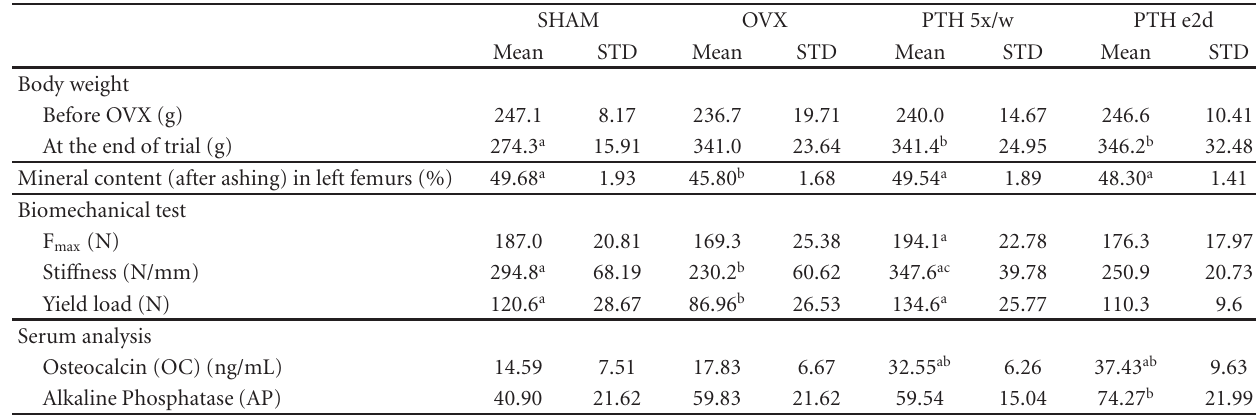
Table 1: Study results. Body weight, mineral content, biomechanical test, and serum analysis of anabolic bone parameters.